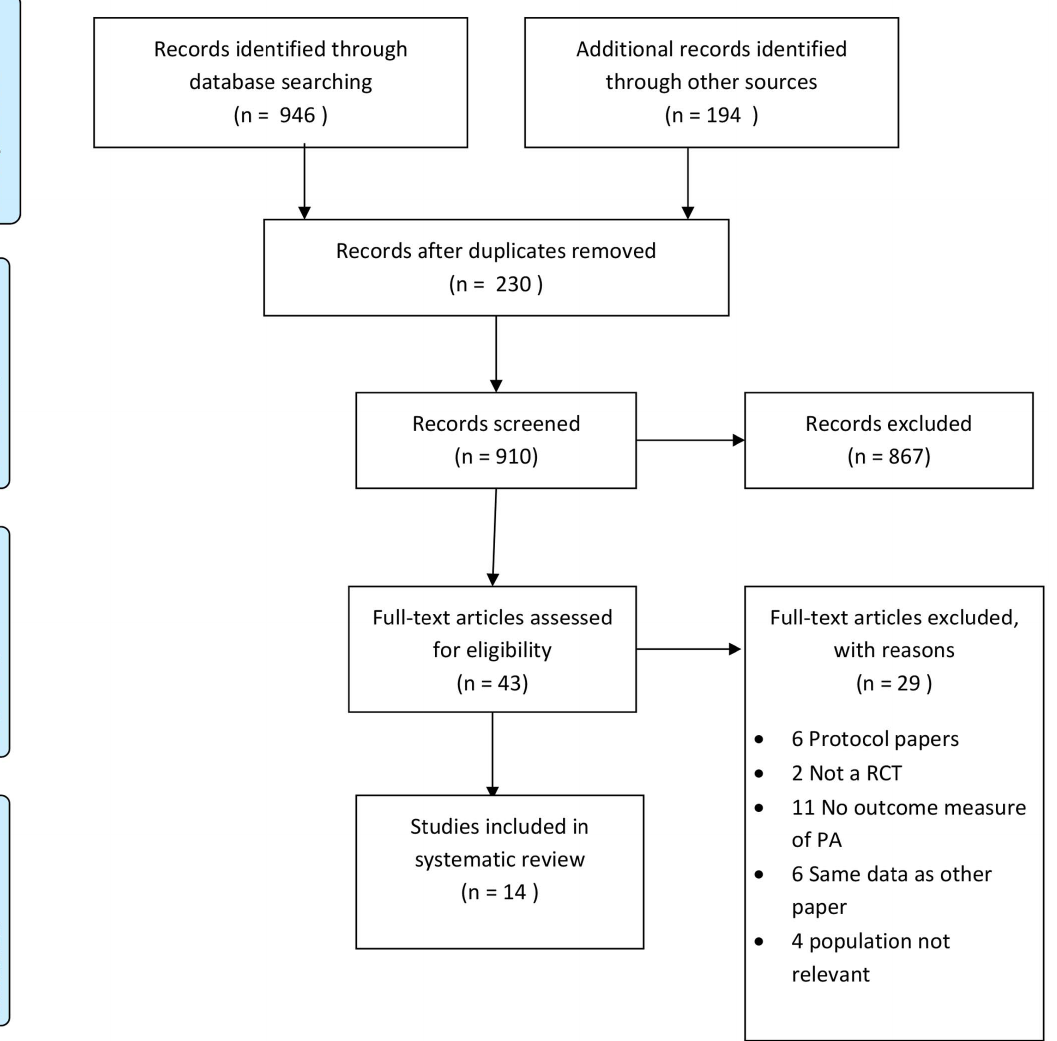
Figure 1. PRISMA flow diagram of literature search for physical activity interventions in pregnancy. The PRISMA flow diagram depicts the flow of information throughout the different phases of this systematic review. It includes the number of records identified, included and excluded and the reasons for exclusions.